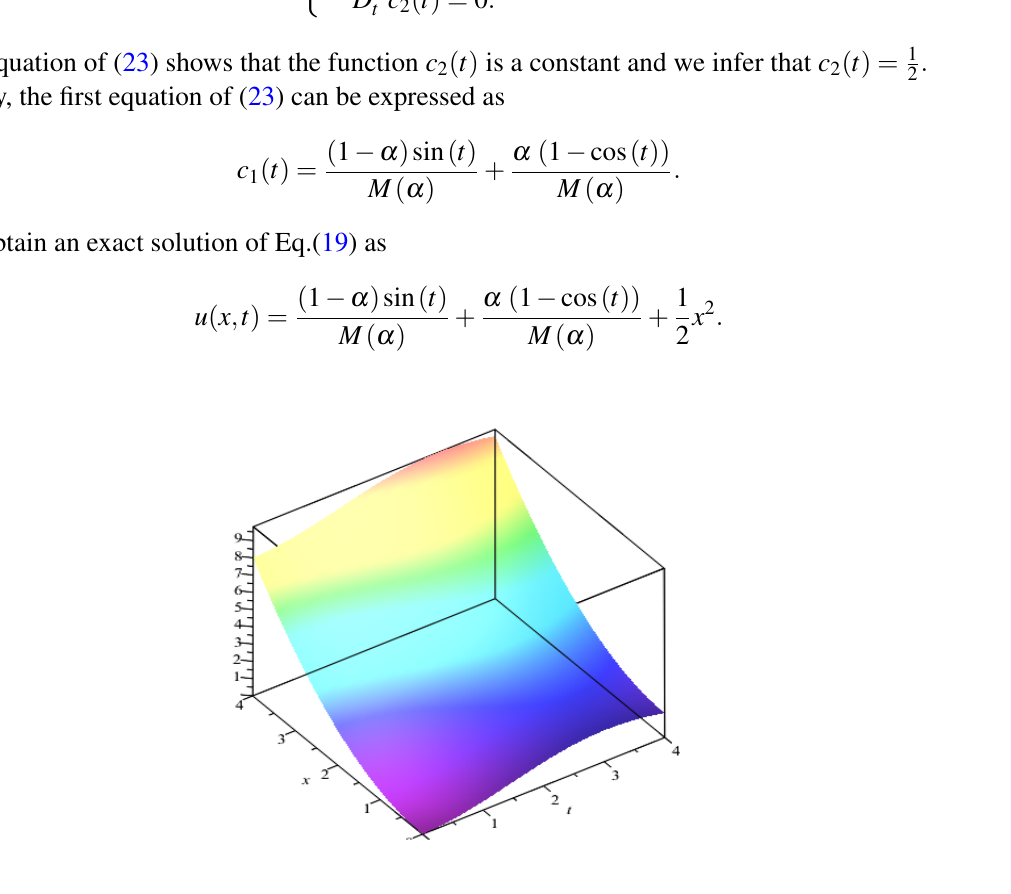
Fig. 2 Profile of the solution (25) for α = 0 . 9